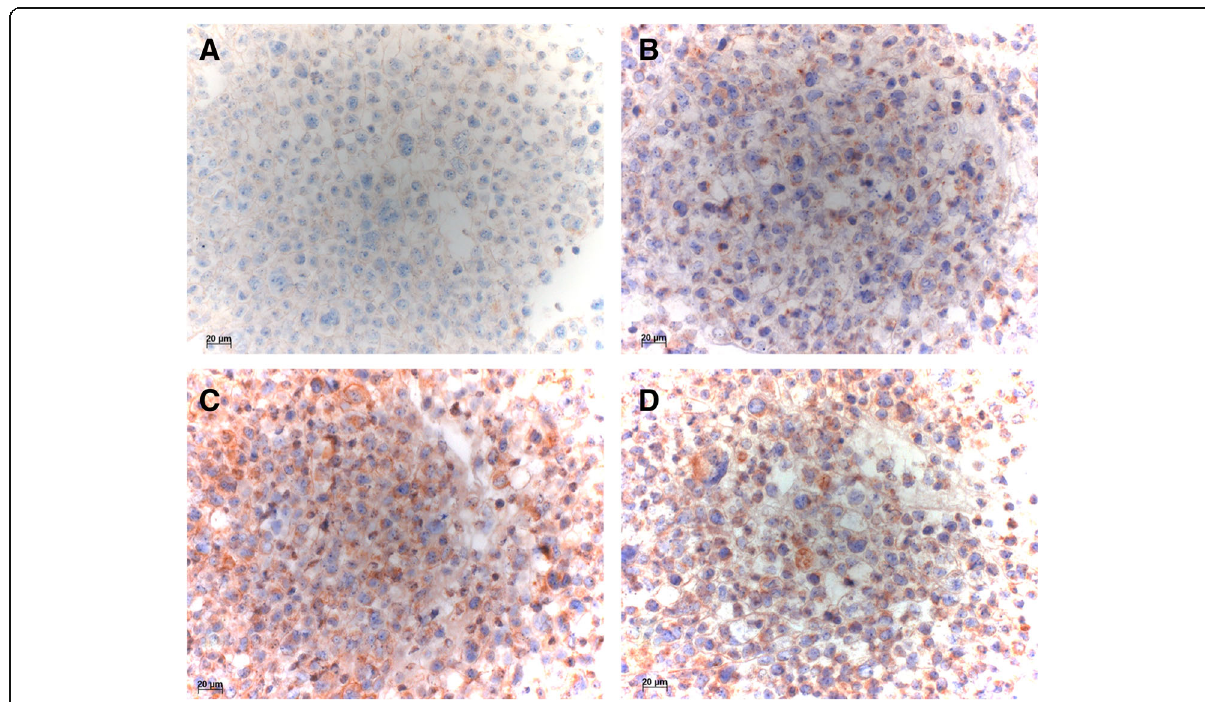
Fig. 4 Immunocytochemical stainings of NCI-H69a with VenA ( a ), AbcA ( b ), NovA ( c ), and TherA ( d ). VenA ( a ) is completely negative in the carcinoma cells, whereas AbcA ( b ) and TherA ( d ) stained many cells, and NovA ( c ) stained almost all cells intensely. Bar 20 μ